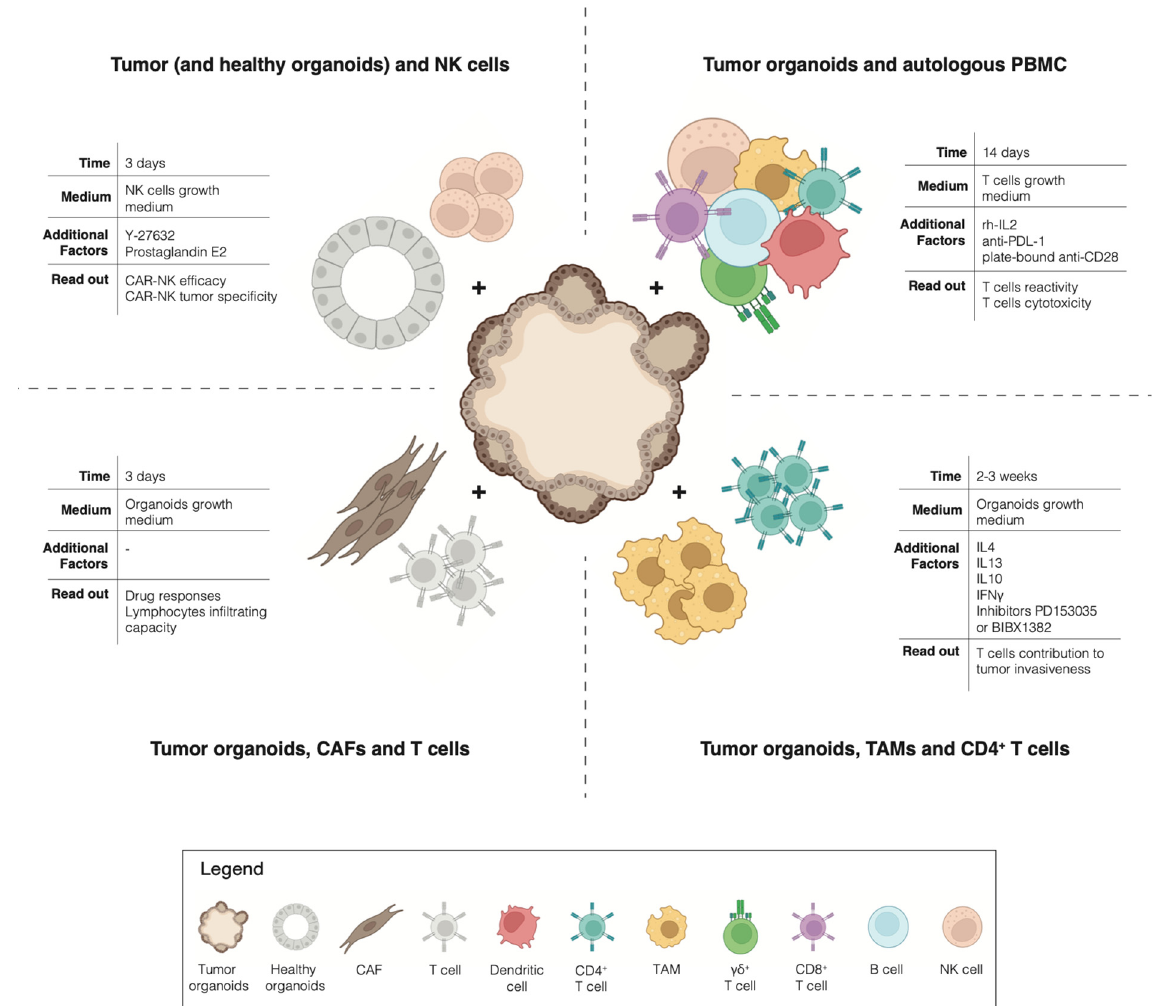
Figure 1. Overview of co-cultures.